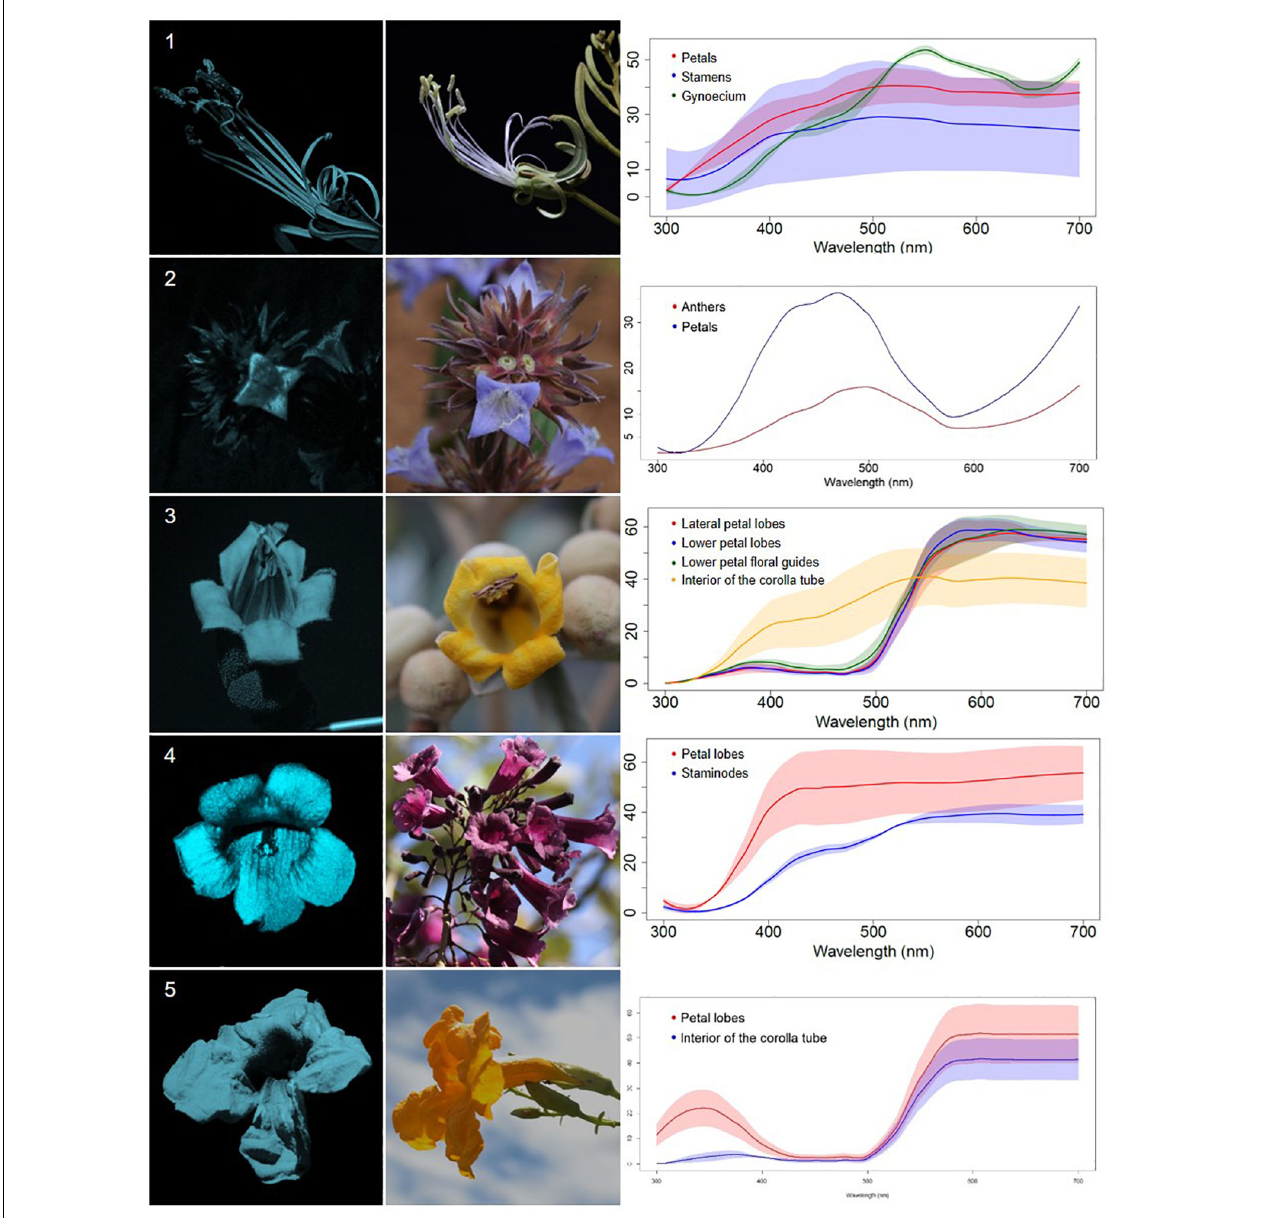
FIGURE 1 | UV-reflecting non-patterned flowers (R) from a Neotropical savanna community. Each row comprises information of one species. First column: UV-photography. Second column: flower as seen by the human eye (conventional photography). Third column: reflectance curves of different portions of the flowers. Row 1. Bauhinia rufa (Bong.) Steud. (Leguminosae). Row 2. Spermacoce poaya A.St.-Hil. (Rubiaceae). Row 3. Zeyheria montana Mart. (Bignoniaceae). Row 4. Jacaranda caroba (Vell.) DC. (Bignoniaceae). Row 5. Adenocalymma peregrinum (Miers) L.G.Lohmann